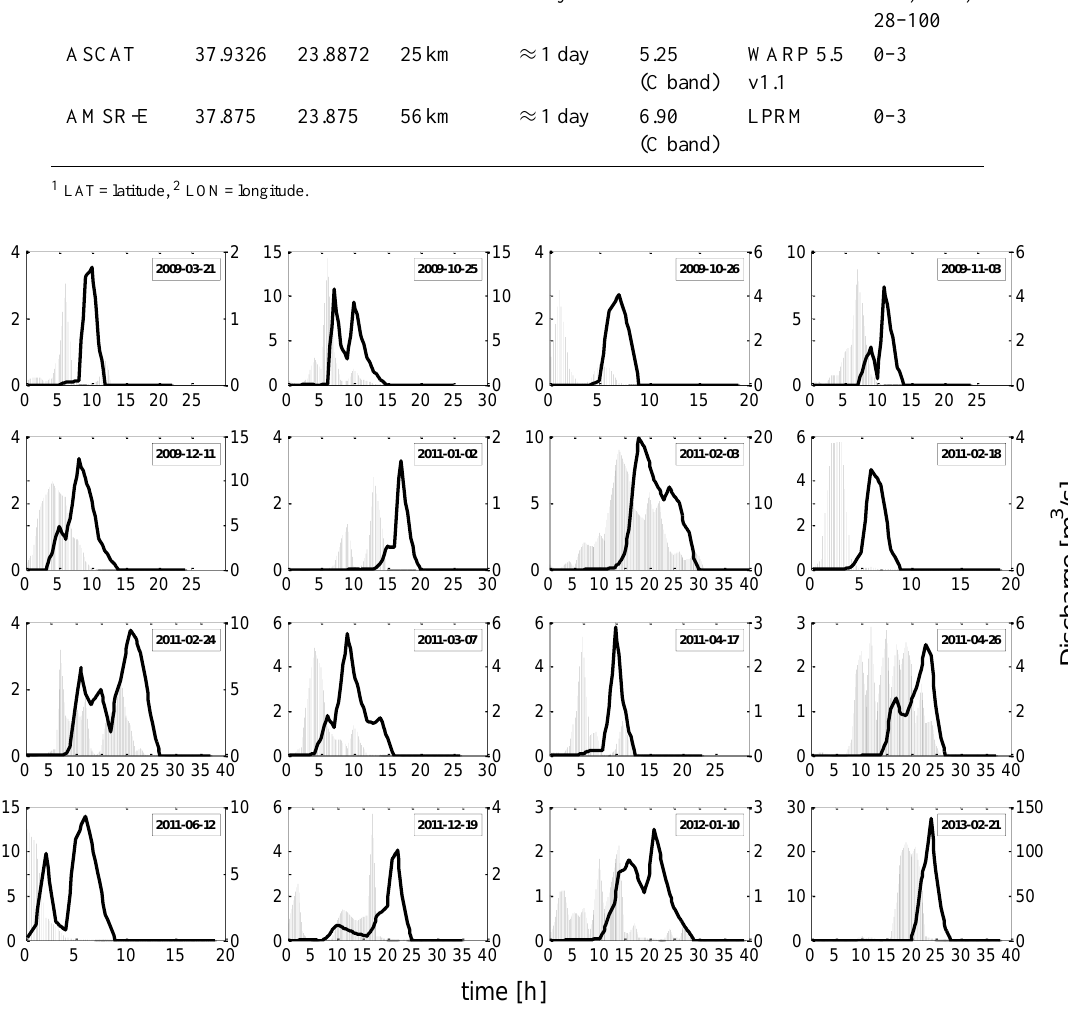
Figure 2: Observed rainfall and discharge for the selected flood events. 4